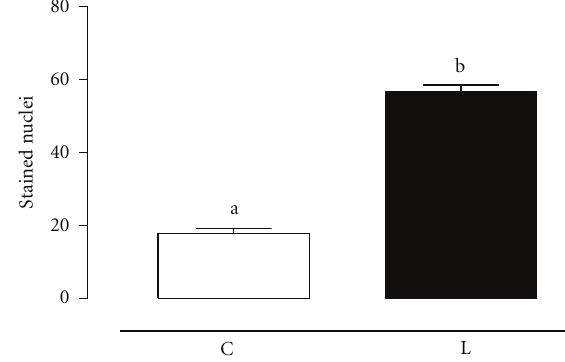
Figure 3: Cellular proliferation evaluated by PCNA technique through immunohistochemistry, in the human hyperplasic prostate tissue after leptin treatment, 50ng/mL, (Leptin) or not (Control) for 3 hours. Data are represented as mean ± SEM of 15 individuals. Di ff erent letters mean statistically significance.